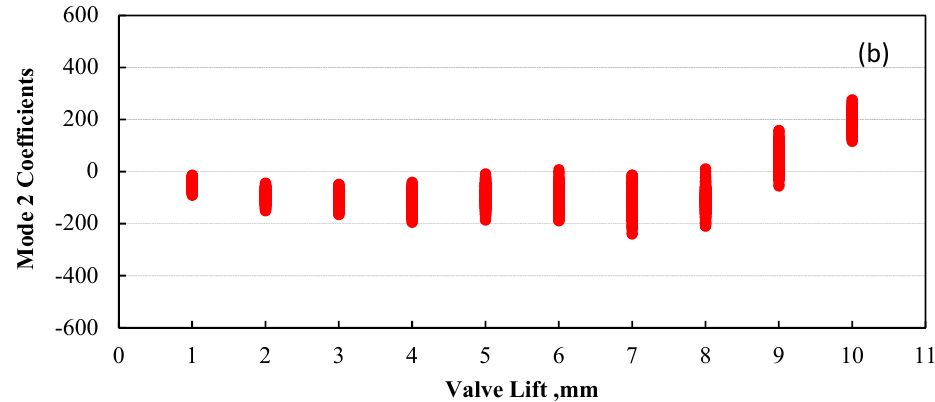
Figure 15. Flow patterns of the second POD mode ( a ) structures of modes 2; ( b ) mode 2 corresponding coefficients at different valve lifts.